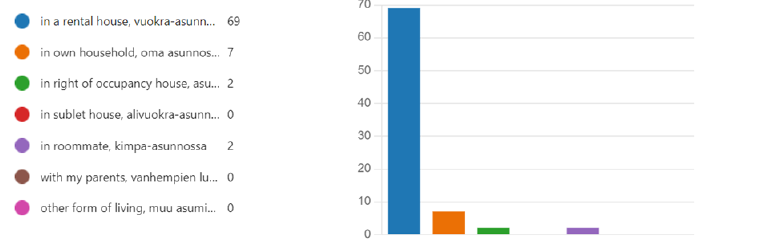
Figure 7. Forms of living for Muslims in Finland. Source: (Authors’